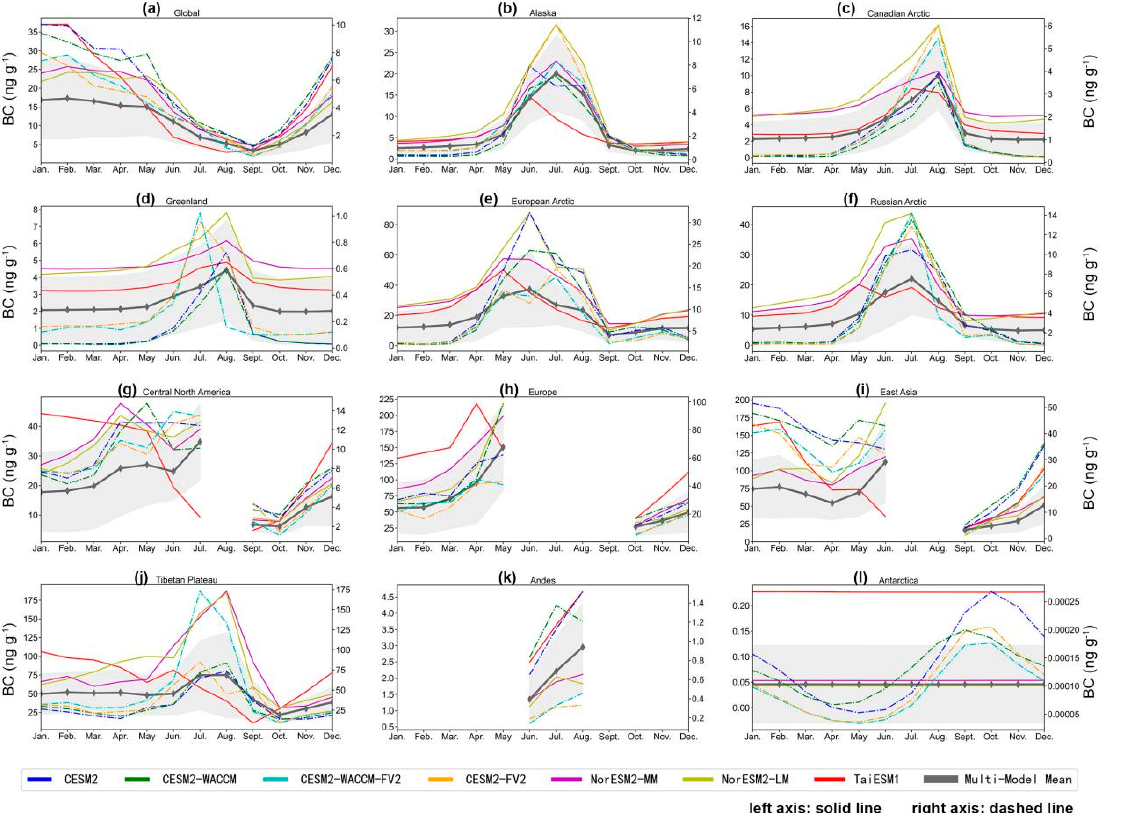
Figure 5. Seasonal BC concentrations in snow (BCS) cycles based on multi-model mean and individual models, averaged over 1850–2014 globally ( a ) and regionally ( b – l ). Gray lines represent multi-model mean BCS, other colors indicate individual model results. The inter-model standard deviation is shown as gray shading. Data were processed with five-point smoothing; values for solid lines are on the left axis and for dashed lines on the right. Models are described in Table 1.